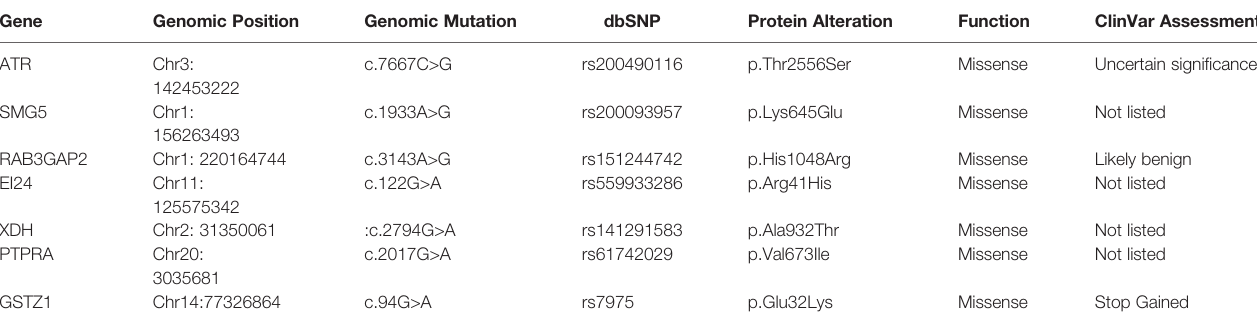
TABLE 1 | Characteristics of the seven candidate variants for familial lung cancer.